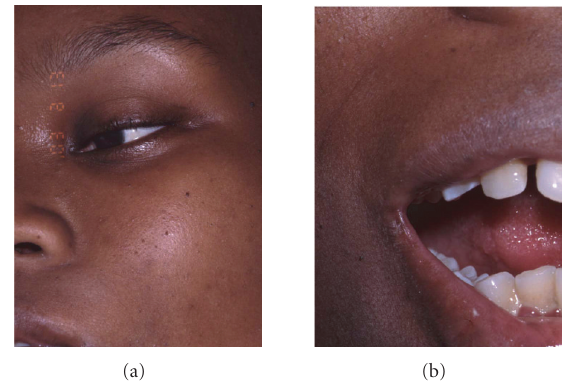
Figure 1: Patient at presentation. (a) General view of the face. Note severe submental and upper neck swellings. (b) Trismus: this is the maximal mouth opening.